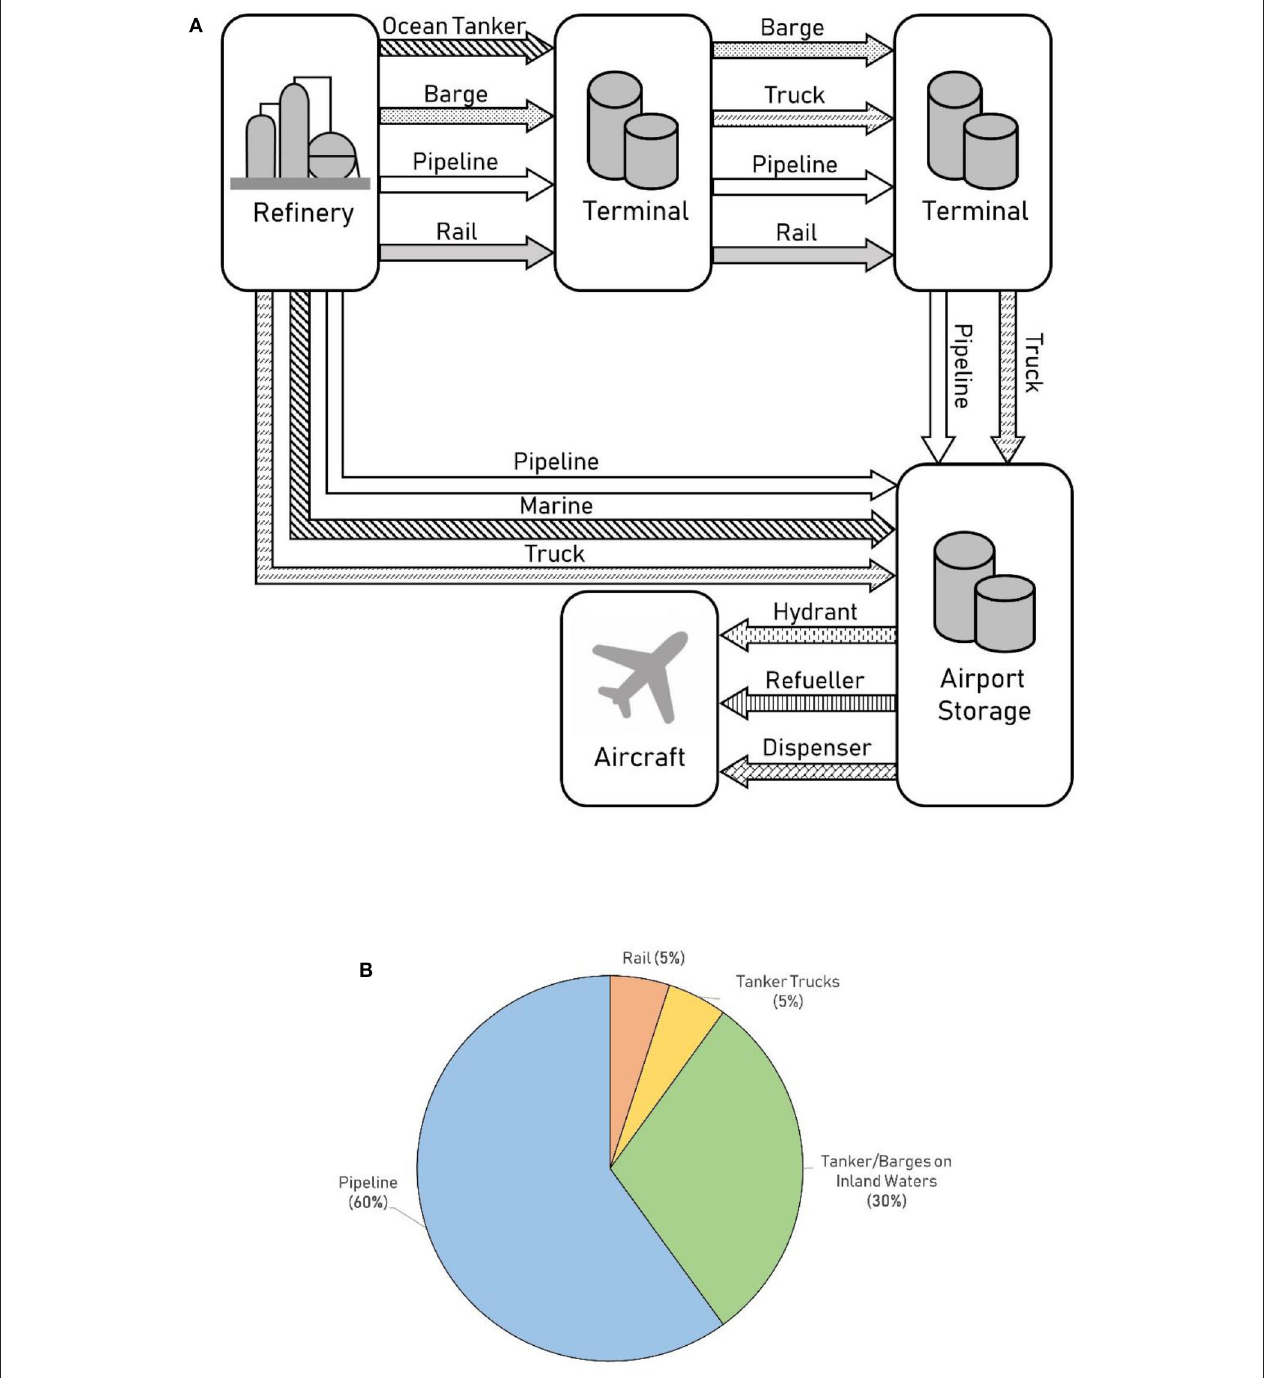
FIGURE 8 | Storage and transport of jet fuel: (A) Typical jet fuel distribution chains (Drawn using data from Hemighaus et al., 2006); and (B) Breakdown of major transport mechanisms for all refined fuel products in the U.S. (Plotted using data from Davidson et al., 2014).